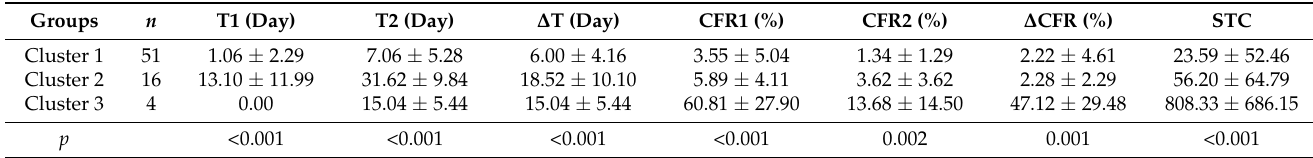
Table 2. Seven parameters of turning points within 3DMA-CFR curves for 71 nations among three clusters (Mean ±